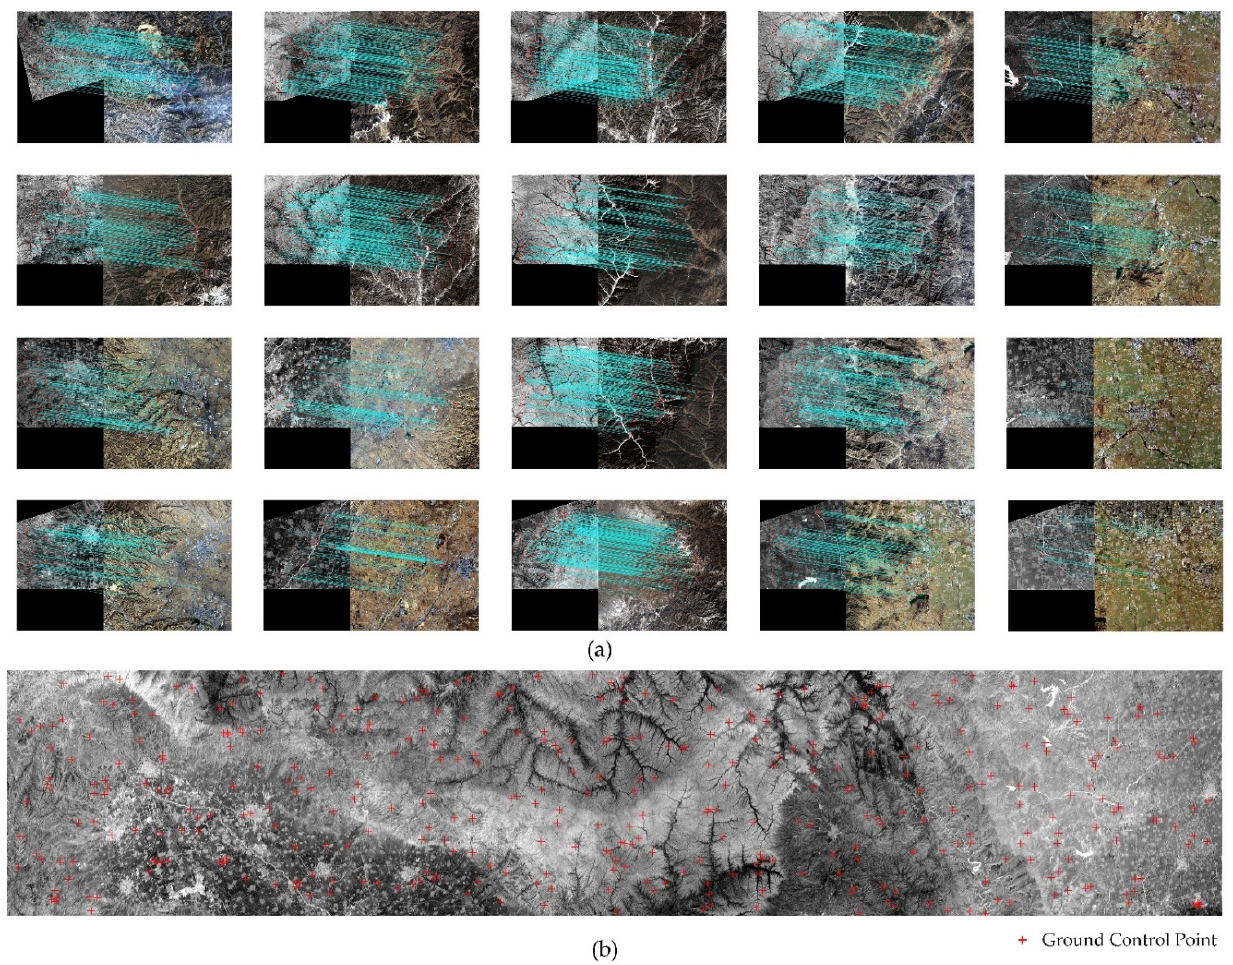
Figure 7. ( a ) Part of registration patch pairs are shown. The left one is TIR image patch with 500 × 500 pixels and the right one is visible image with 800 × 800 pixels. Totally 80 patches are needed for registration and 20 registration results are displayed; ( b ) all GCPs extracted by the registration process are plotted on the original L1A TIR image.